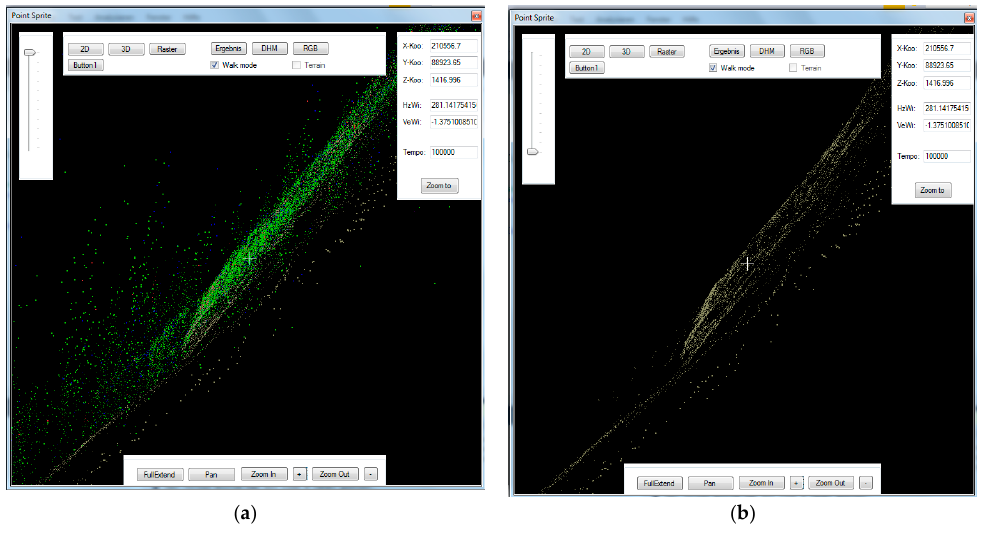
Figure 8. Screenshot of the computer program with vegetation points ( a ); and screenshot of the computer program only with ground points ( b ).